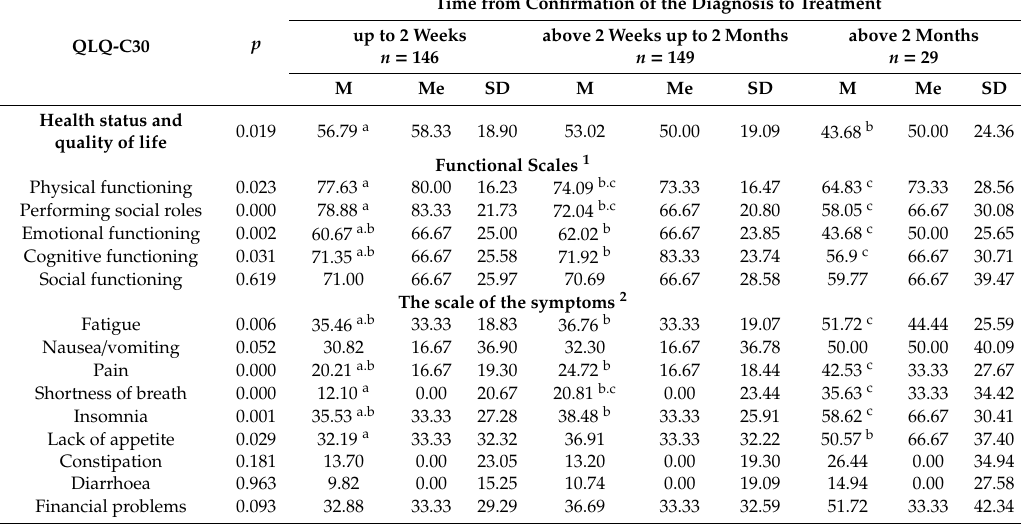
Table 7. Assessment of women’s quality of life—categories related to QLQ-C30 and the time from diagnosis confirmation to treatment.